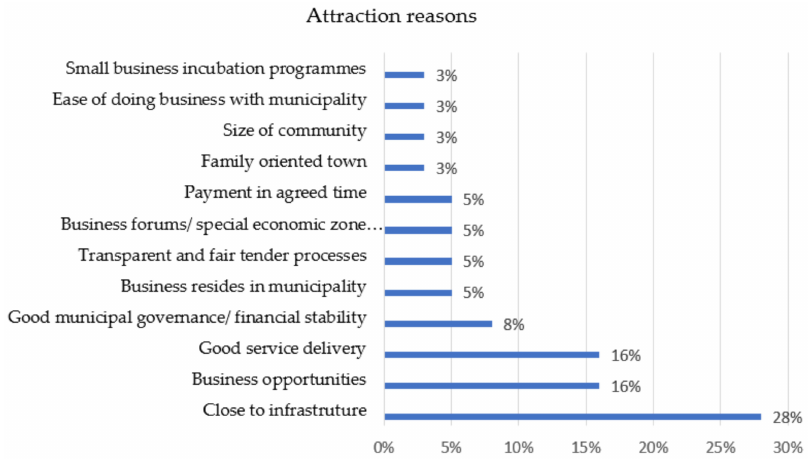
Figure 1. Business investment